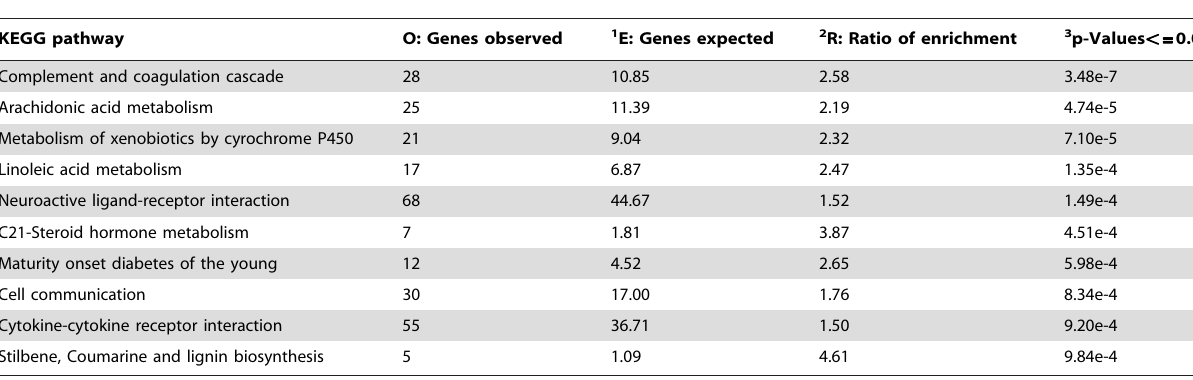
Table 2. Significantly enriched KEGG pathways for predominantly-off genes ( p , = 0.01).